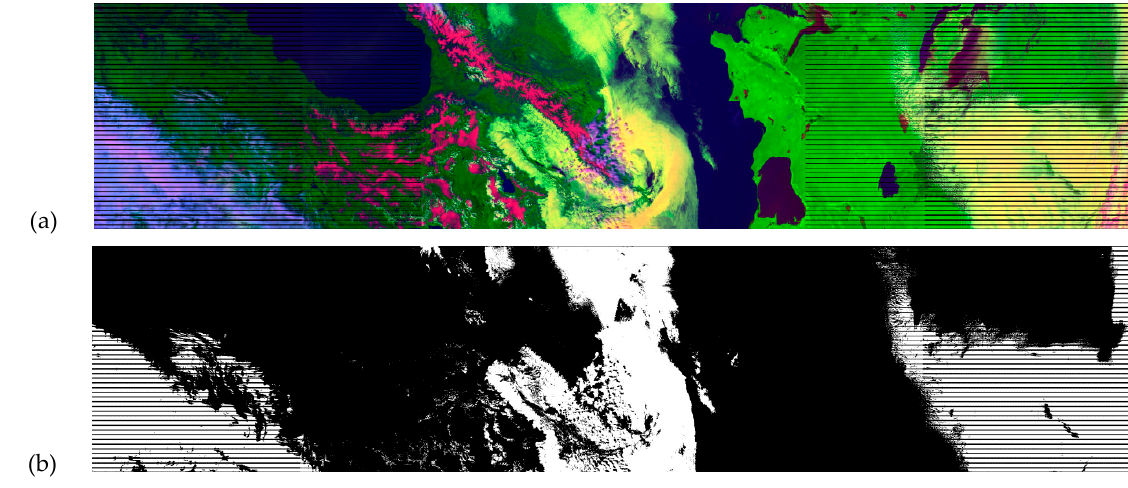
Figure 1. VIIRS imagery collected on 31 March 2013 at 0939 UTC. Figure 1 a shows a color composite image constructed by putting VIIRS M1 (412 nm), M10 (1610 nm), and M16 (12013 nm) bands into an RGB image, respectively. Water clouds are yellow, colder ice clouds are blue-purple and warmer (possibly mixed phase) ice clouds are pink, snow and ice surfaces are red, unfrozen water is dark blue, vegetated land features are dark green, and more desert regions are light green. Figure 1 b is an image of the MGCNC data derived from the human analysis of the VIIRS imagery using the cloud truth software.